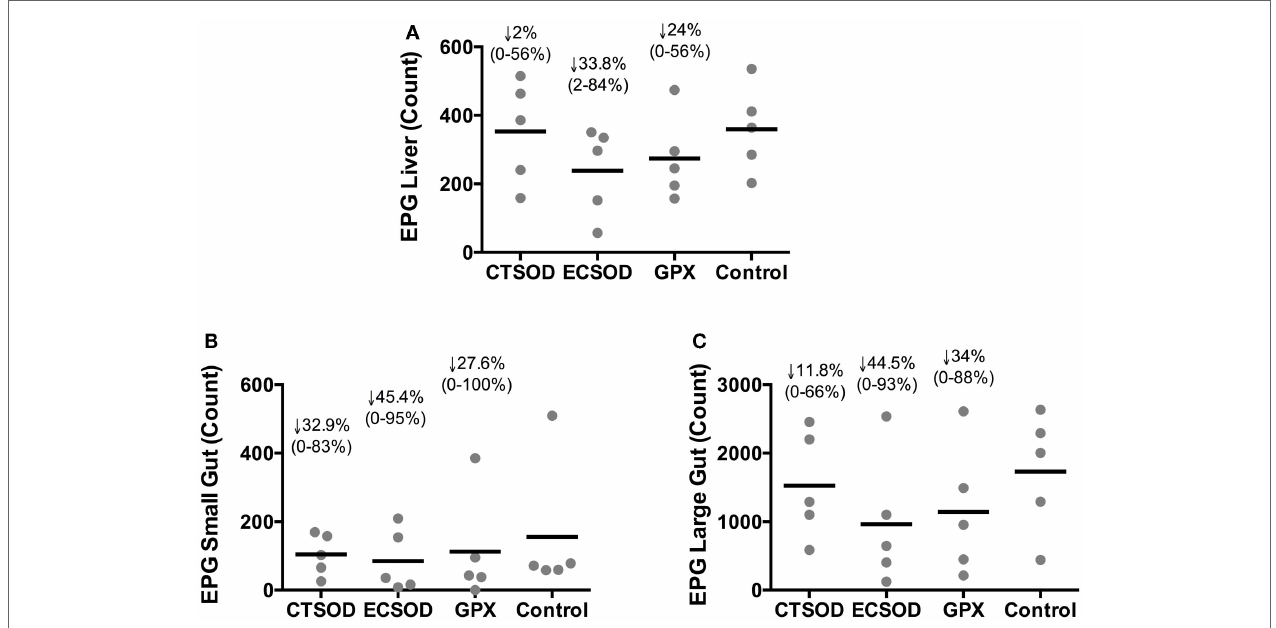
reduction (represented by the arrow), the range (minimal–maximal, represented between brackets), and the statistical p -value were expressed in comparison to the mean average of the Control group. Non-parametric (Kruskal–Wallis, Mann–Whitney) tests were applied. Values were considered statistically significant when p < 0.05.